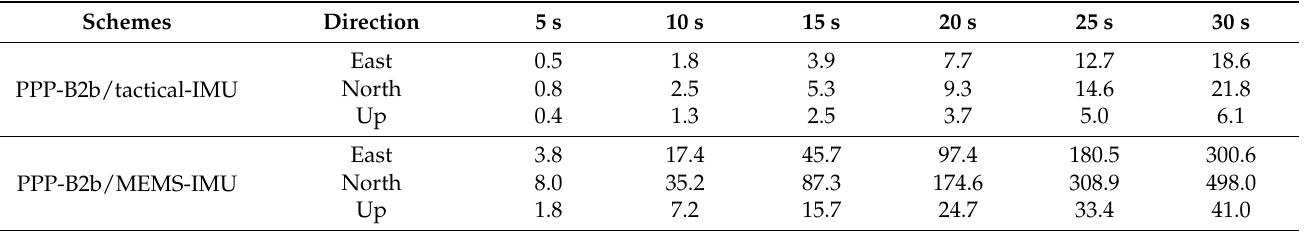
Table 4. Statistics of positioning errors for PPP-B2b/INS loosely coupled integration during GNSS outages (unit: cm).